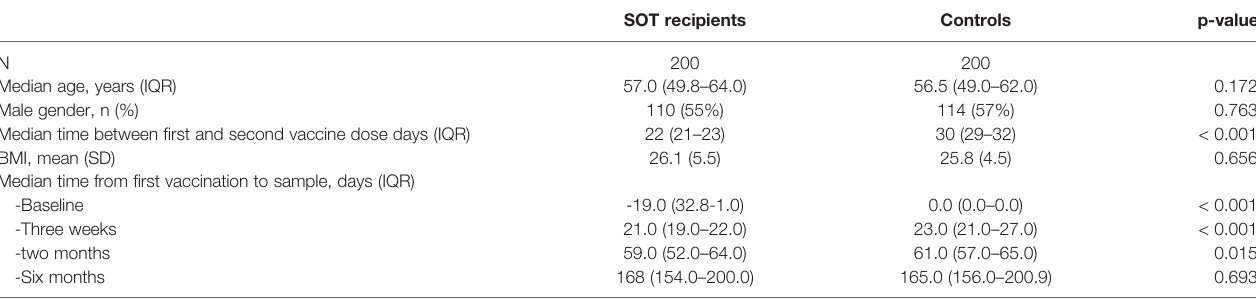
IQR, Interquartile range; SD, standard